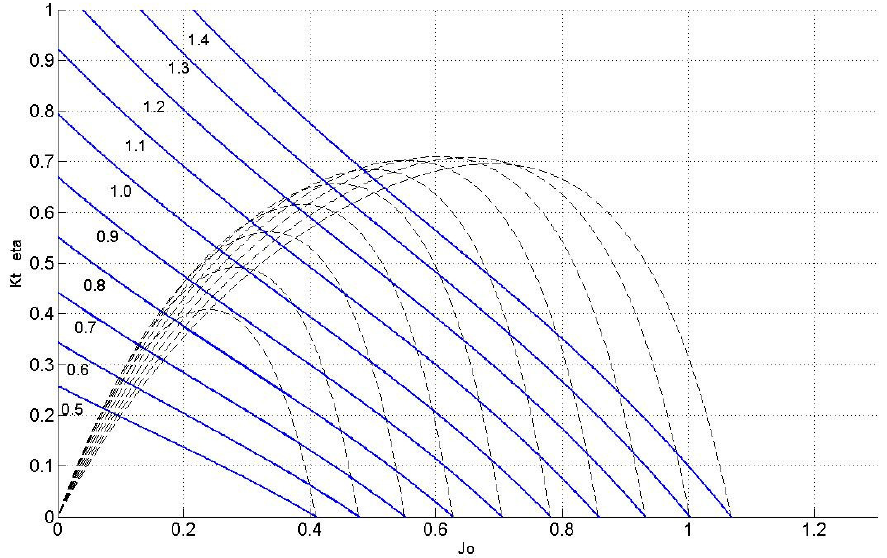
Figure 2. Wageningen Ka series propellers 4 blades, A E / A 0 = 3/4 and P / D = 0.5 − 1.4 adapted with permission from Ref. [34], 2010,